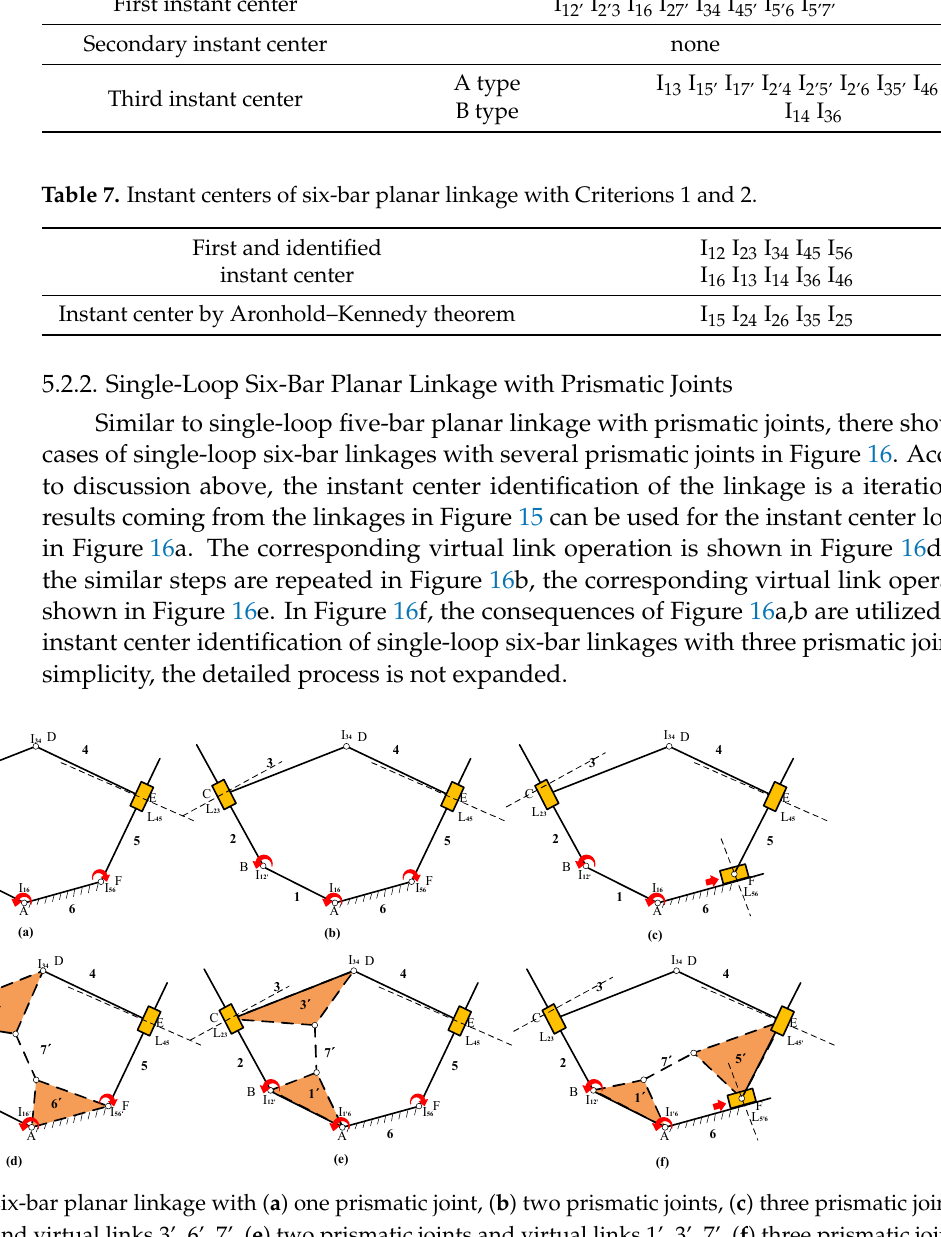
Figure 15. Single-loop six-bar planar linkage with virtual links. Table 5. Instant centers of six-bar planar linkage without virtual links. Table 6. Instant centers of six-bar planar linkage with virtual links. First instant center